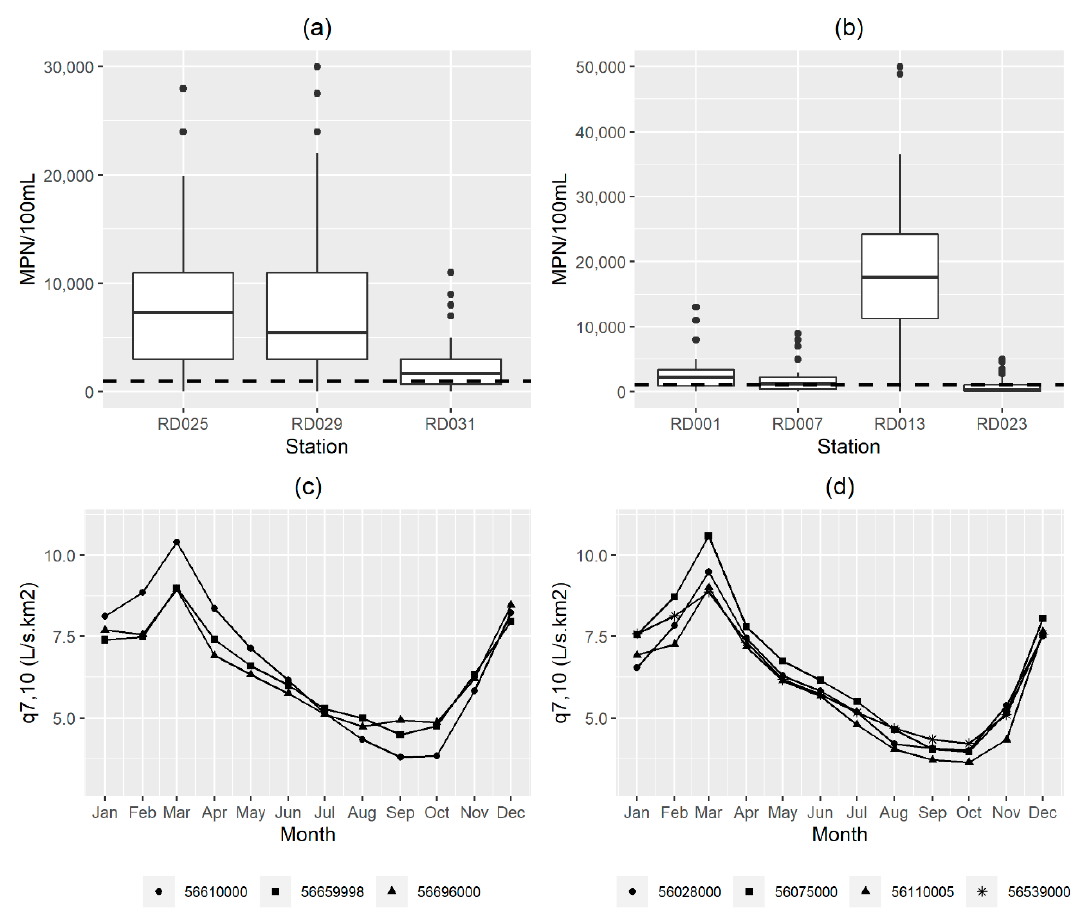
Figure 2. E. coli concentrations in the ( a ) Piracicaba, and ( b ) Piranga basins (the dashed line represents the maximum allowed concentration in Class 2 rivers), and monthly streamflow variation in ( c ) Piracicaba and ( d ) Piranga basins.